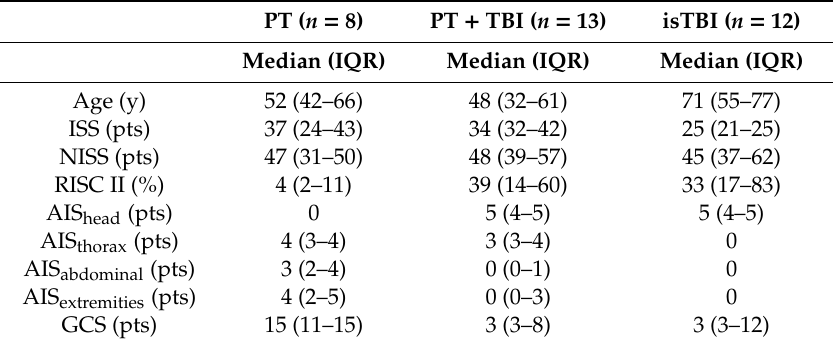
Table 1. Demographic and injury